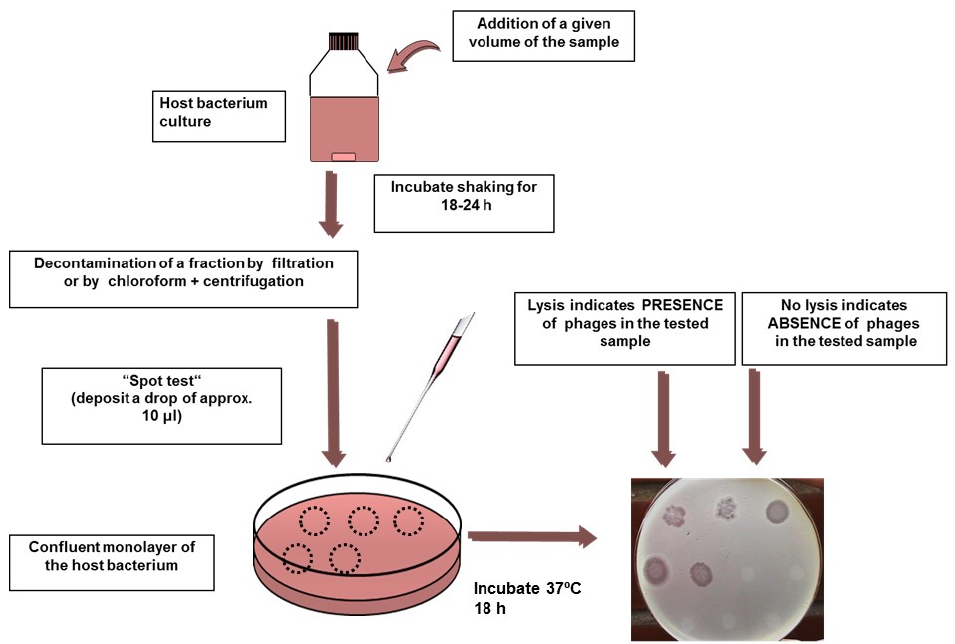
Figure 3. Detection of bacteriophages by the Spot Test method.